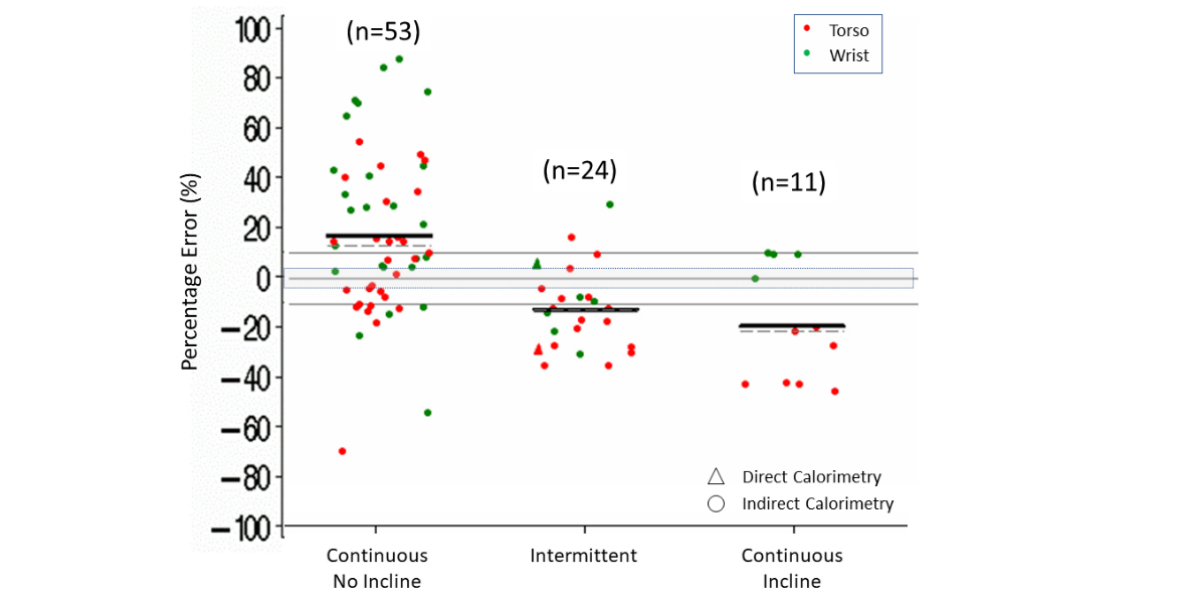
Figure 10. Energy expenditure percentage error in controlled settings. Type of ambulation (continuous no incline, continuous incline, intermittent) by body placement (torso, wrist). Dark lines indicate mean (horizontal). Dashed lines indicate median (horizontal). Triangles indicate measurement by direct calorimetry. Gray shading indicates ±3% measurement